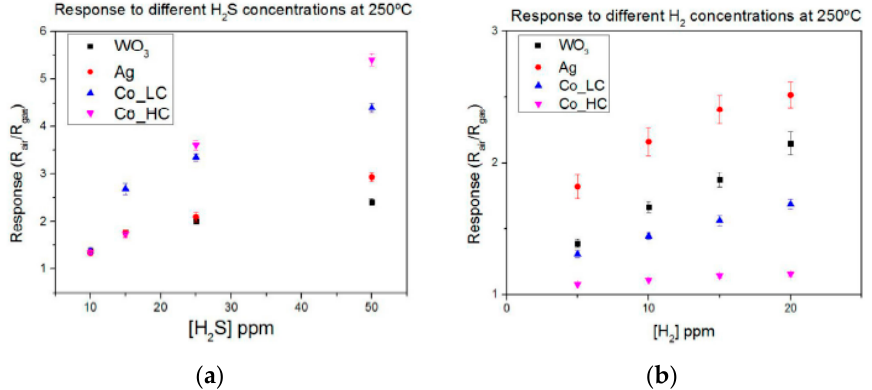
Figure 4. ( a ) Pure WO 3 and silver doped WO 3 sensors comparison; ( b ) Pure WO 3 and cobalt doped sensors